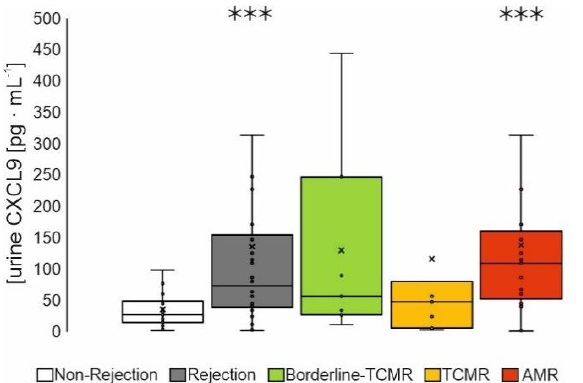
Figure 4. Urine samples of patients of the 2nd patient cohort were collected at the day of biopsy. Patients were grouped according to the histopathological scoring of their biopsy into patients with non-rejection ( n = 40), borderline-TCMR ( n = 8), TCMR (T-cell mediated rejection, n = 7) and AMR (antibody-mediated rejection, n = 23). Boxplots show the median value, the mean and the standard error of the mean. Wilcoxon test revealed a statistical significance between groups with *** p < 0.001 as indicated.